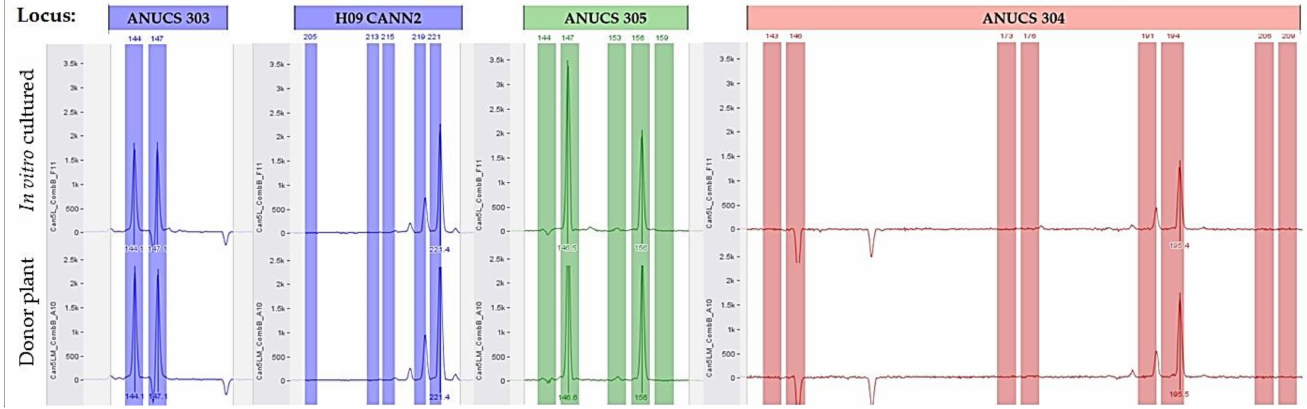
Figure 6. The simple sequence repeat amplification pattern obtained for mother plant (donor) and in vitro cultured micropropagated plant, using loci: ANUCS 303, H09 CANN2, ANUCS 305, and ANUCS